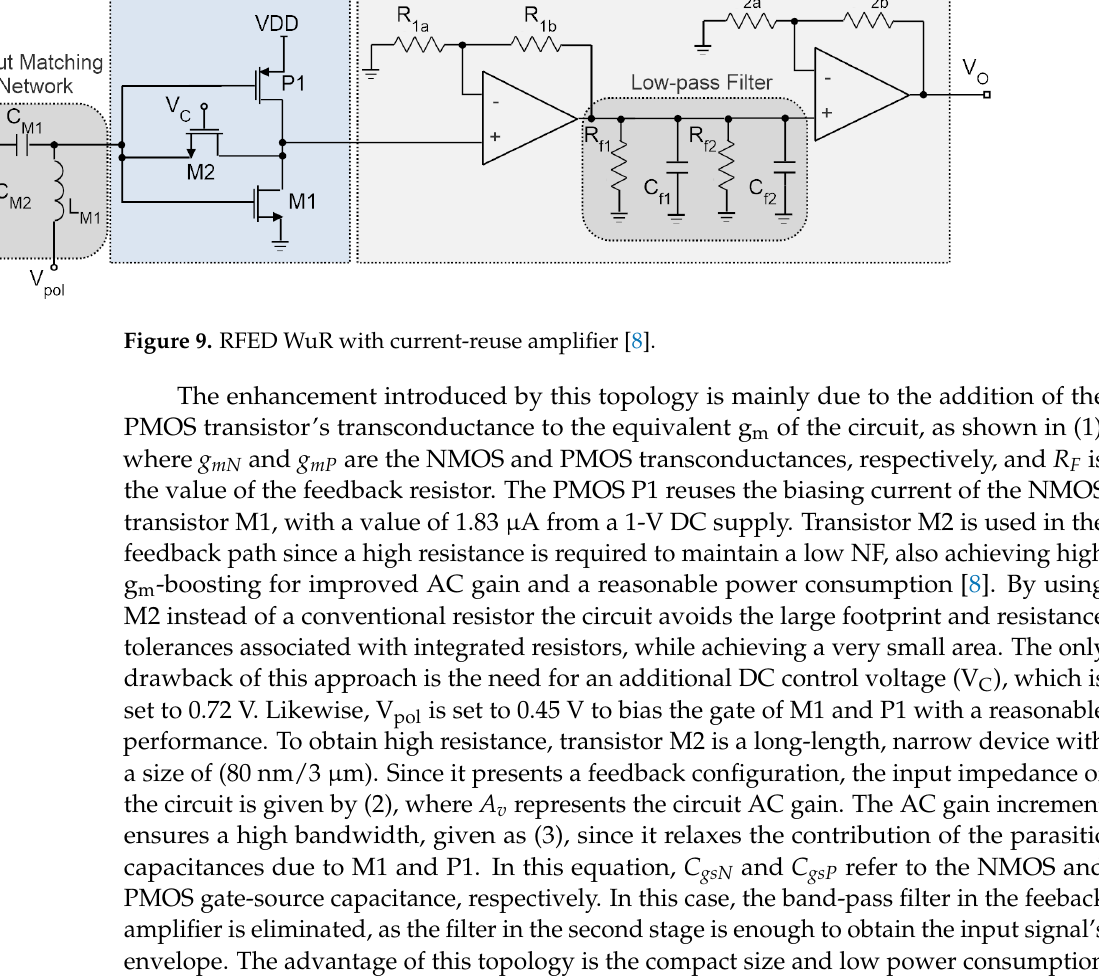
Figure 8. Layout of the two-stage feedback amplifier, total size of 230 × 160 μm 2 .